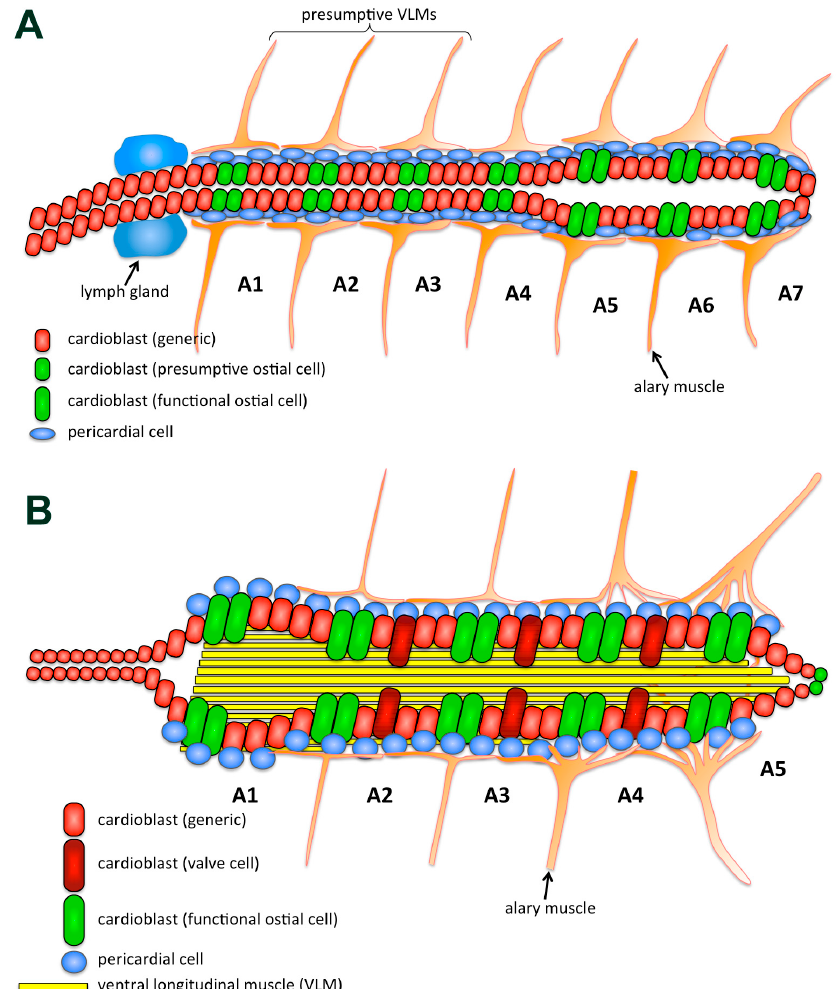
Figure 1. Schematic drawings of dorsal vessels from late stage Drosophila embryo ( A ) and adult fly ( B ) (not to scale). The cell types discussed in the text are color-coded as indicated. The adult heart is remodeled from the larval dorsal vessel, which involves histolysis of cells from abdominal segments A6 and A7, transdifferentiation of the three anterior pairs of alary muscles into ventral longitudinal muscles (VLMs), differentiation of presumptive ostial cells from the larval aorta into functional ostia, formation of three valves, formation of the conical heart chamber, and a reduction in the number of pericardial cells.